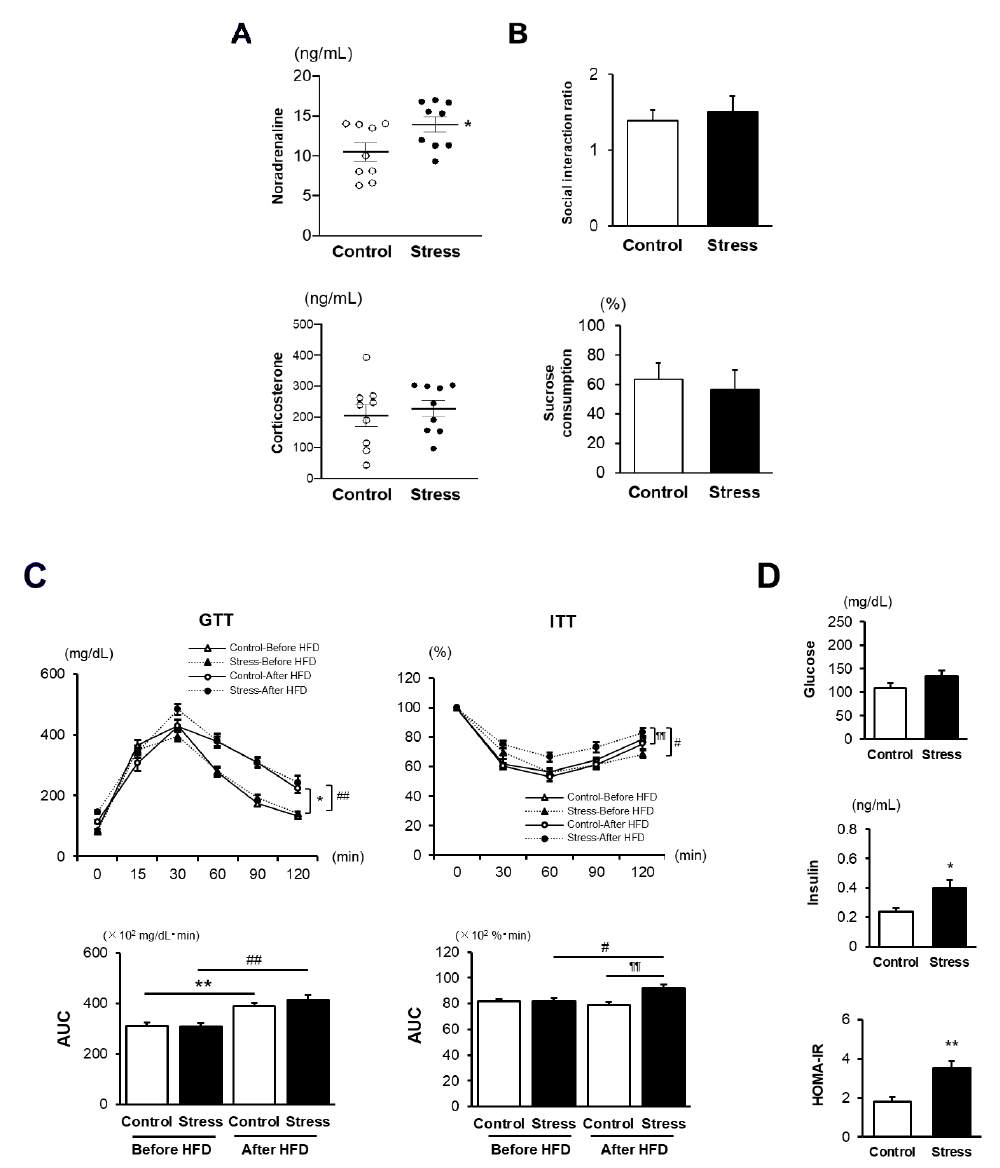
Figure 1. Social stress (SS) increases the susceptibility to the development of high-fat diet (HFD)-induced insulin resistance (IR). ( A ) Serum noradrenaline and corticosterone levels after SS. Values represent the mean ± SEM for nine (Control) and nine (Stress) mice. * p < 0.05 vs. Control. ( B ) Social interaction ratio and sucrose consumption after SS. Values represent the mean ± SEM for 10 (Control) and 10 (Stress)